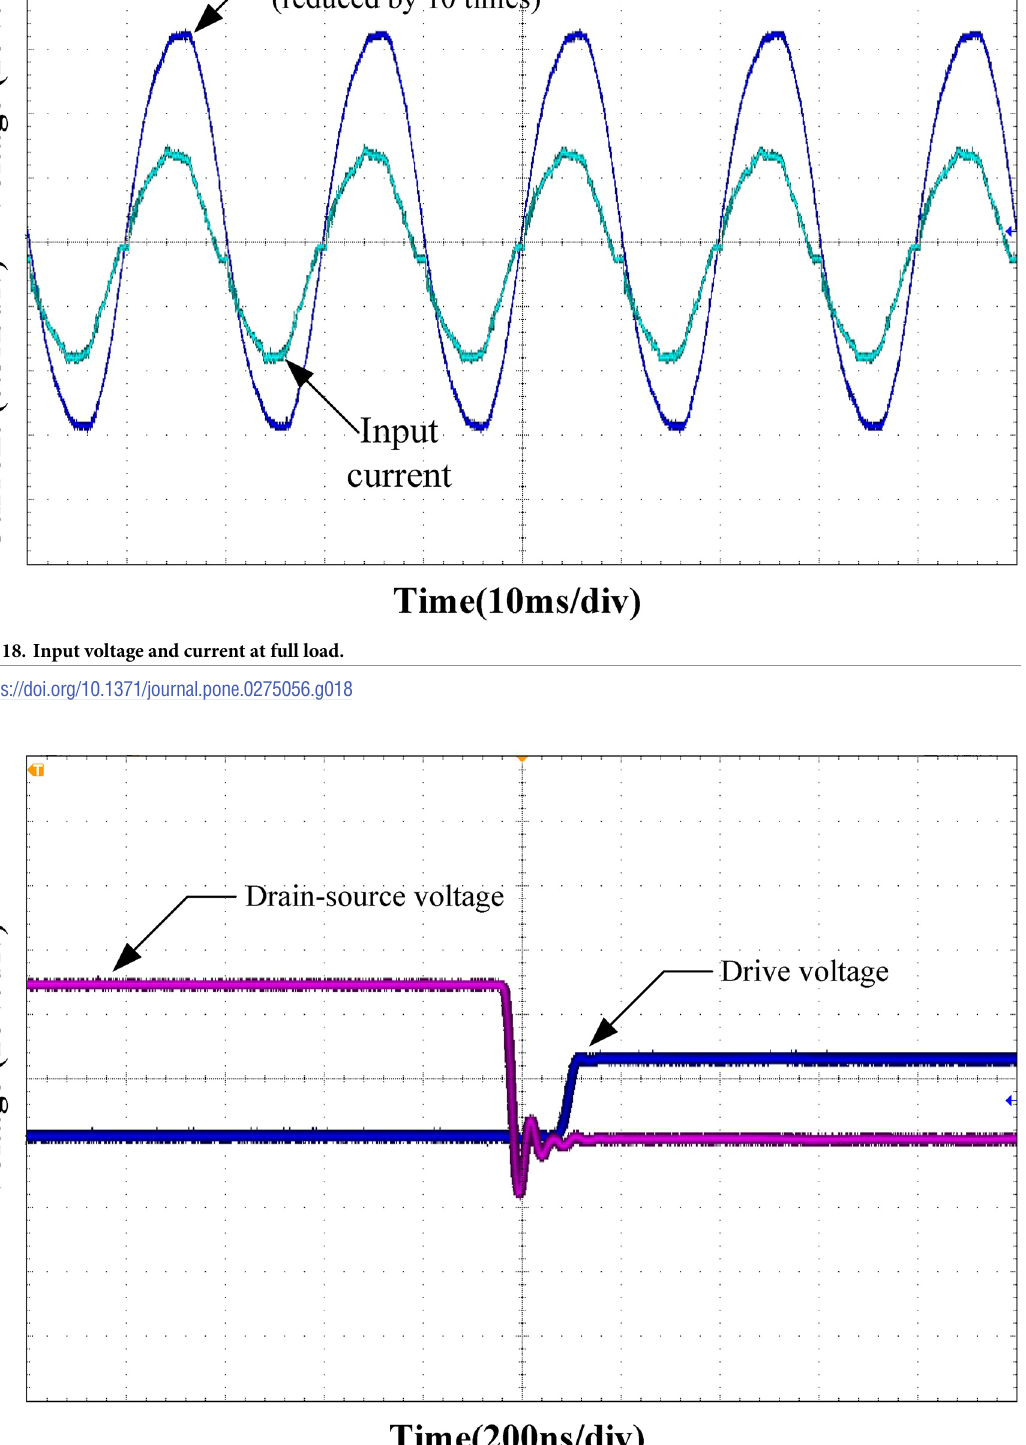
PLOS ONE | https://doi.org/10.1371/journal.pone.0275056 September 22,